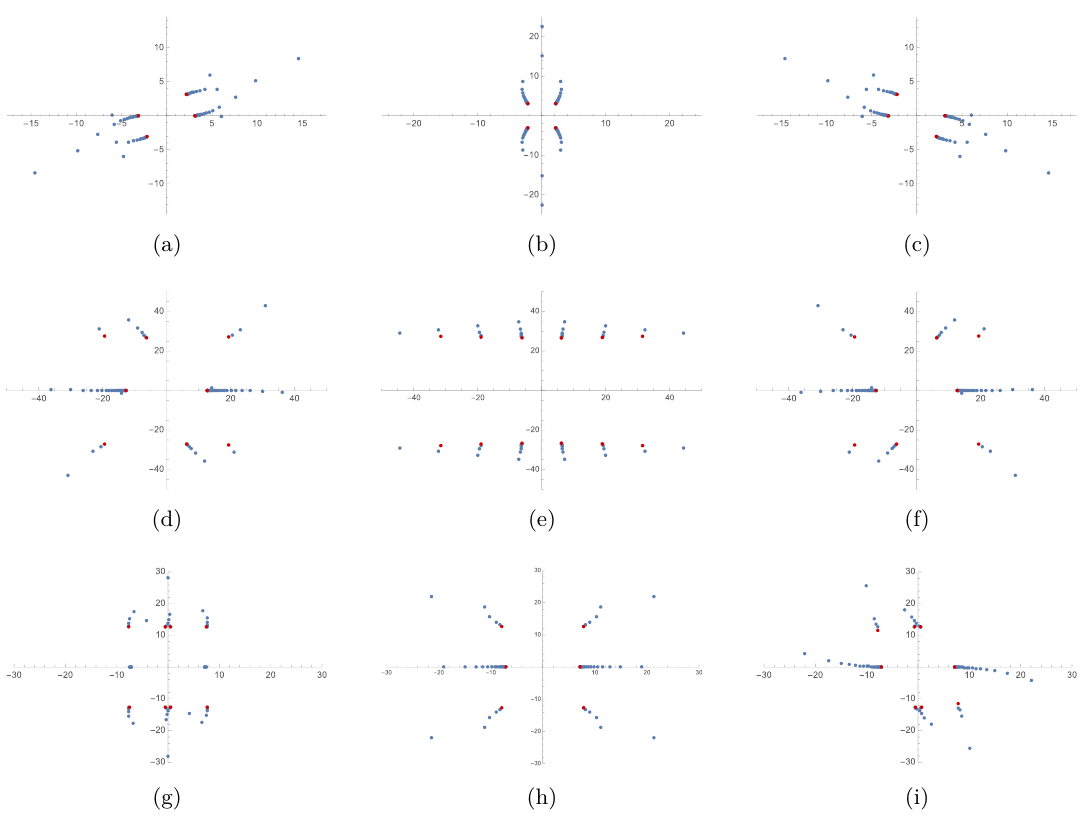
Figure 7 . Poles of the Padé-Borel transform for various quantum periods. The first row shows the poles for Π (left), Π (center) and Π (right) in strong coupling region at u = 0 , γ [1 , 0 , 0] γ [0 , 1 , 1] γ [ − 1 − 1 , 1] (left), Π (center) and m = − 1 / 10 and Λ = 1 . The second row shows the poles for Π γ γ [0 , 2 , 0] [1 , 0 , 0] Π (right) in weak coupling region for u = 2 , m = 0 and Λ = 1 / 5 . The third row shows the γ [ − 1 , − 1 , 1] poles for Π (left), Π (center) and Π (right) in weak coupling region for u = − 2 , γ [1 , 0 , 0] γ [0 , 2 , 0] γ [ − 1 , − 1 , 1] m = 1 / 10 and Λ = 1 . The first poles in each accumulated series are denoted by red dots. The position of such poles correspond approximately to the central charges of BPS states with non-zero intersection numbers w.r.t. the charge γ under [ − , − , − ]